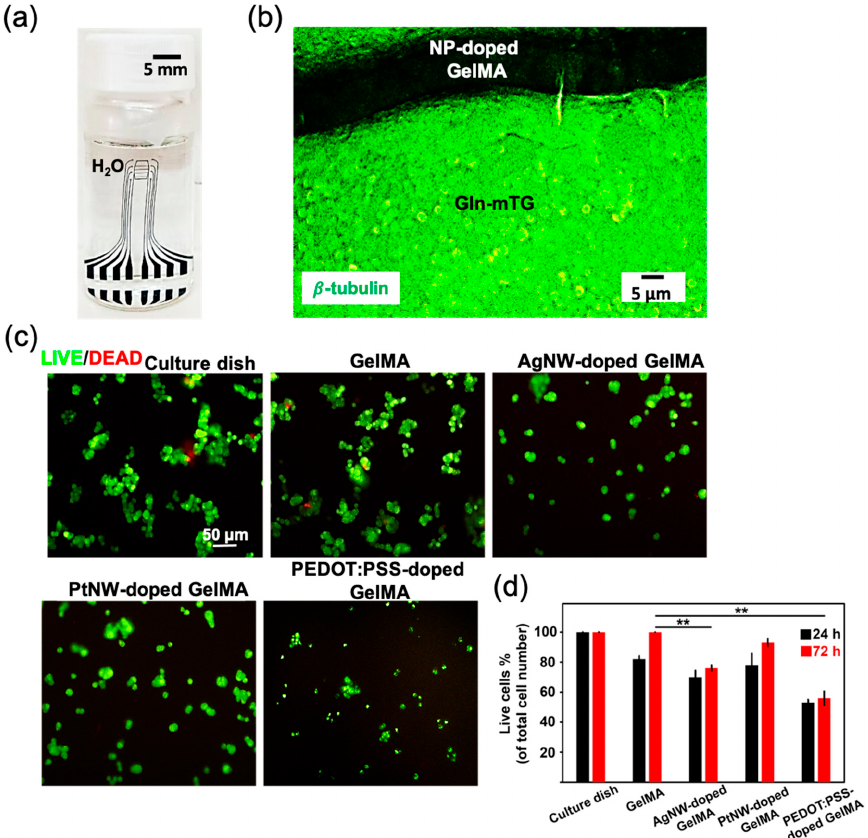
Figure 7. ( a ) An optical image demonstrating no morphology change of the hydrogel device. ( b ) A fluorescence image of PC12 cell differentiation on the hydrogel device after 7 days. ( c ) Live–Dead assay of the cells was performed after 72 h. ( d ) Percentage of survived cells as calculated under a fluorescence microscope (* indicates significant difference in different groups for comparison, ** p < 0.01 as compared with GelMA group).